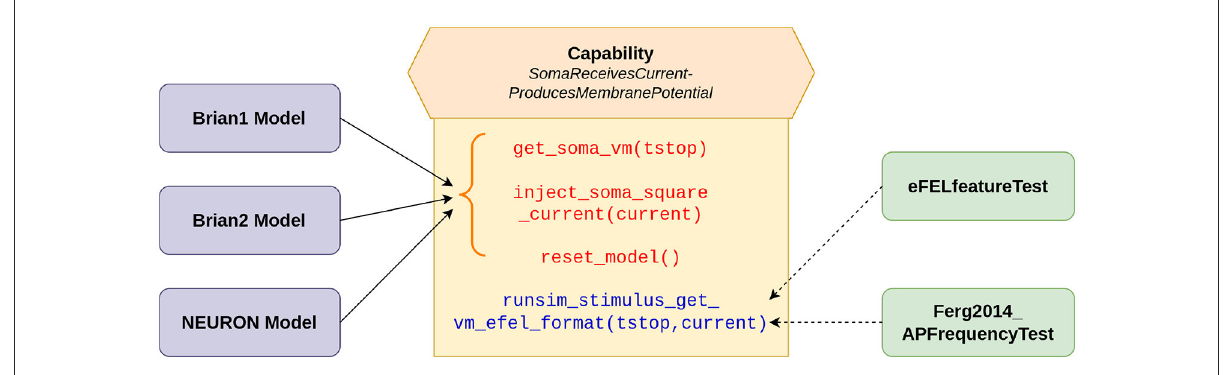
FIGURE1 SciUnit based workflow of running validation tests. The capability acts as an interface between the models and tests, and defines the functionalities demanded from the models. The solid arrows indicate the functions (in red) that are to be implemented by our models; these functions represent more granular functionalities. The function (in blue) combines these more basic functions, to provide a more comprehensive workflow, and can be directly utilized (shown by dashed arrows) by the tests to evaluate the